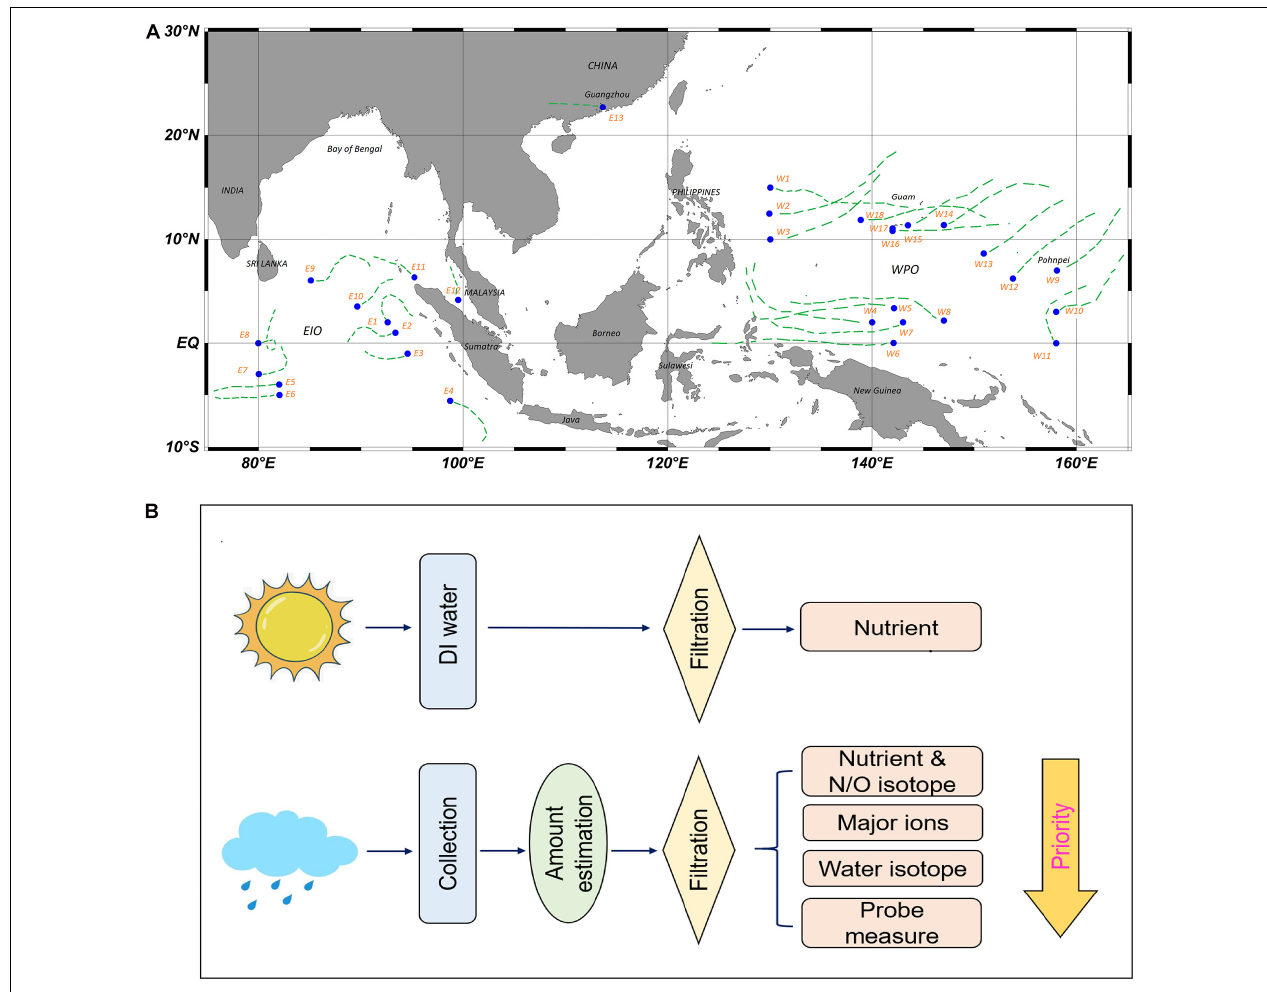
FIGURE 1 | Sampling sites in both EIO and WPO cruises (A) , the dash lines indicate 72 h transport pathway of atmospheric particles at an altitude of 1,000 m (back-trajectory analysis). (B) Sketch of the sampling procedure, including atmospheric blank analysis (only WPO) and rainwater collection/filtration.